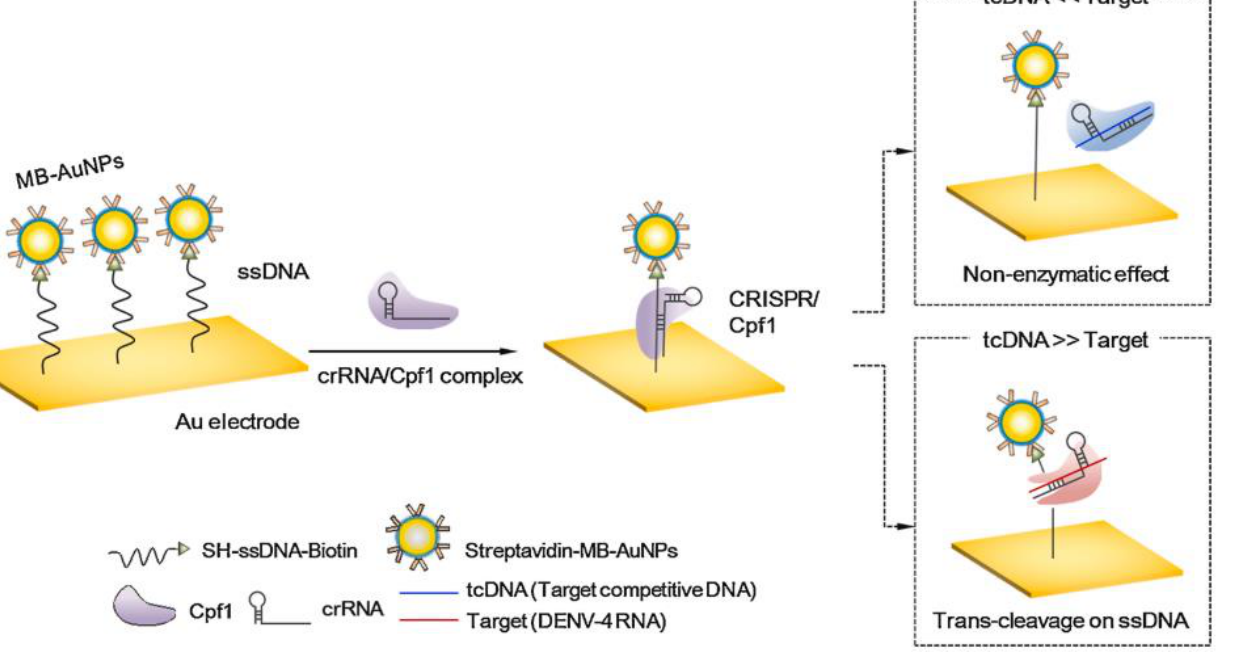
Figure 5. The CRISPR system for detection of RNA Dengue Virus (DENV). (Reprinted with permis- sion from Elsevier [93]. Copyright and Licensing.). Table 3. Detection of tropical diseases using the CRISPR/Cas system.